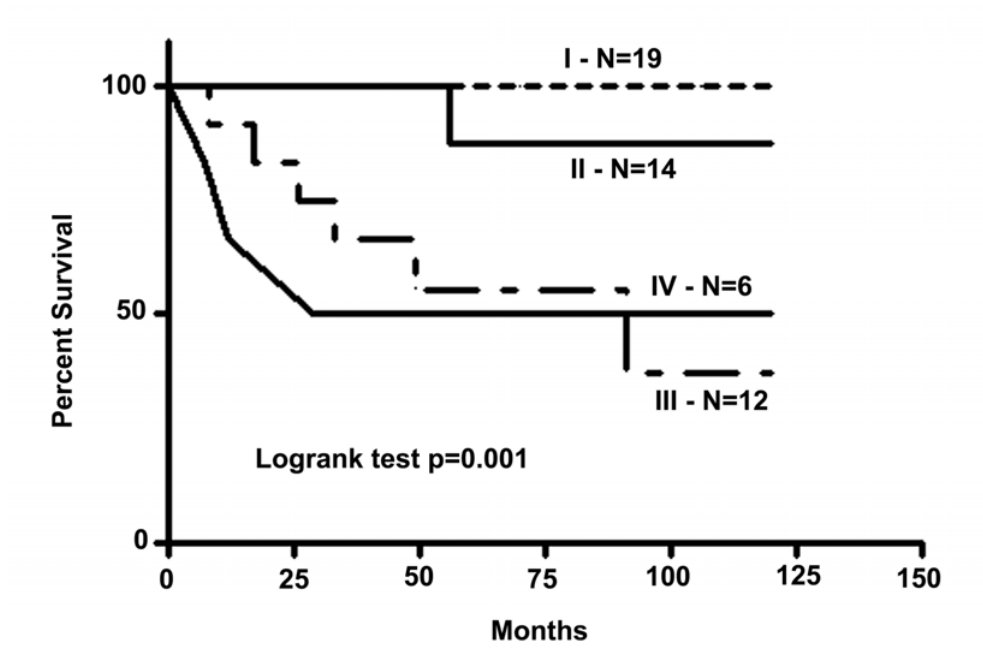
Figure 1 – Disease-free survival rates according to tumor